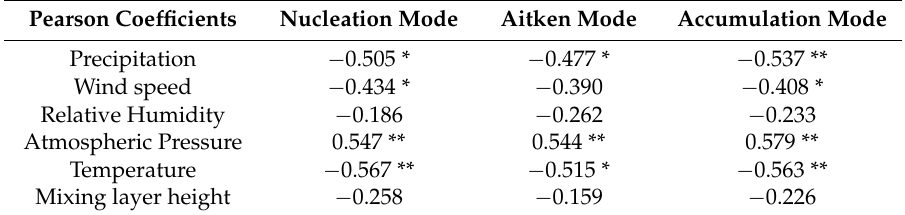
Table 2. Pearson coefficients between particle number concentrations in the three modes and